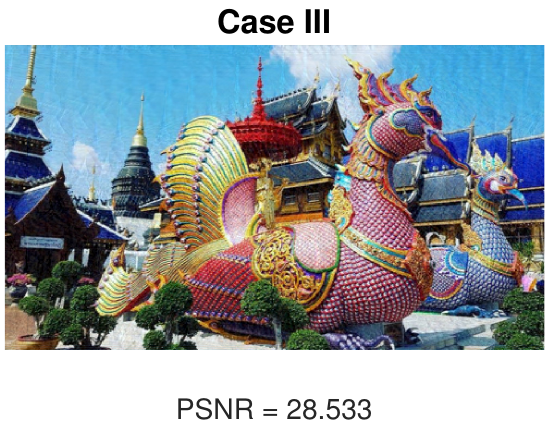
Figure 20. The reconstructed RGB image with their PSNRs for three different cases using the proposed algorithm presented in 10,000 iterations, respectively.